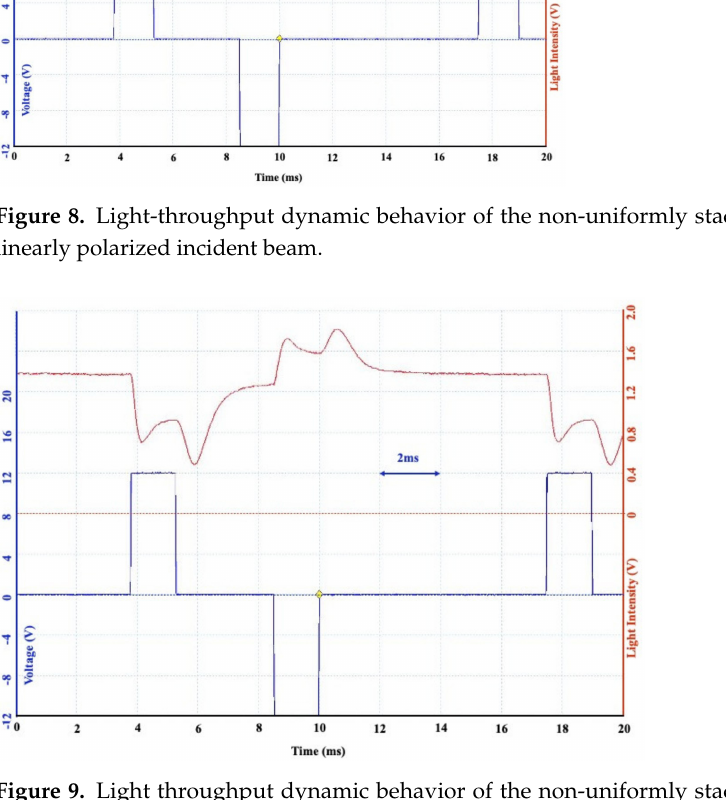
Figure 9. Light throughput dynamic behavior of the non-uniformly stacked SSD-LC panel for a circularly polarized incident